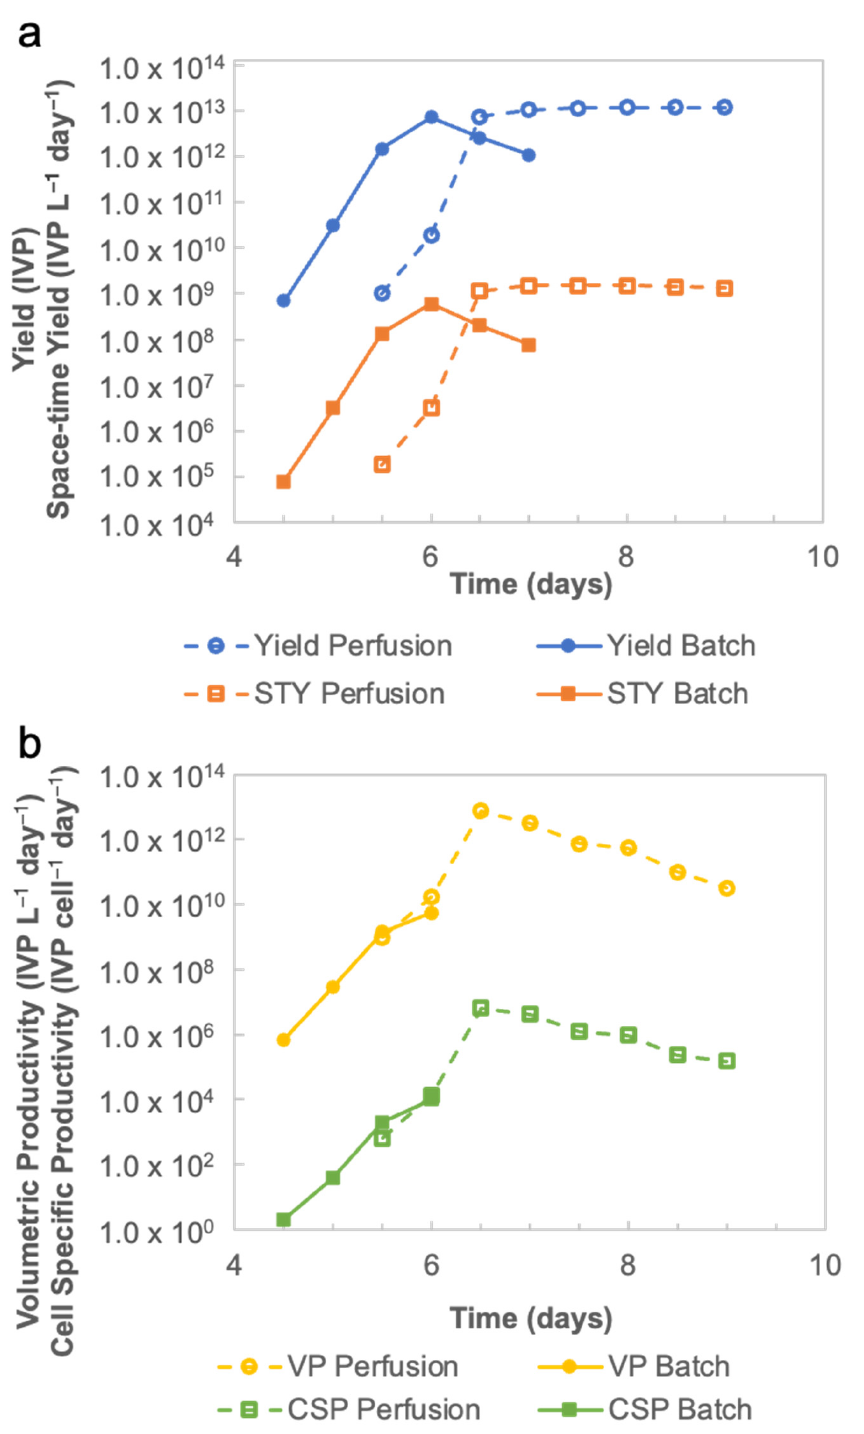
Figure 7. ( a ) Total yield and space–time yield curves of rVSV-SARS-CoV-2 production in the perfusion bioreactor and batch-based bioreactor. ( b ) Volumetric productivity and cell-specific productivity curves of rVSV-SARS-CoV-2 production in the perfusion mode bioreactor and the batch mode bioreactor.